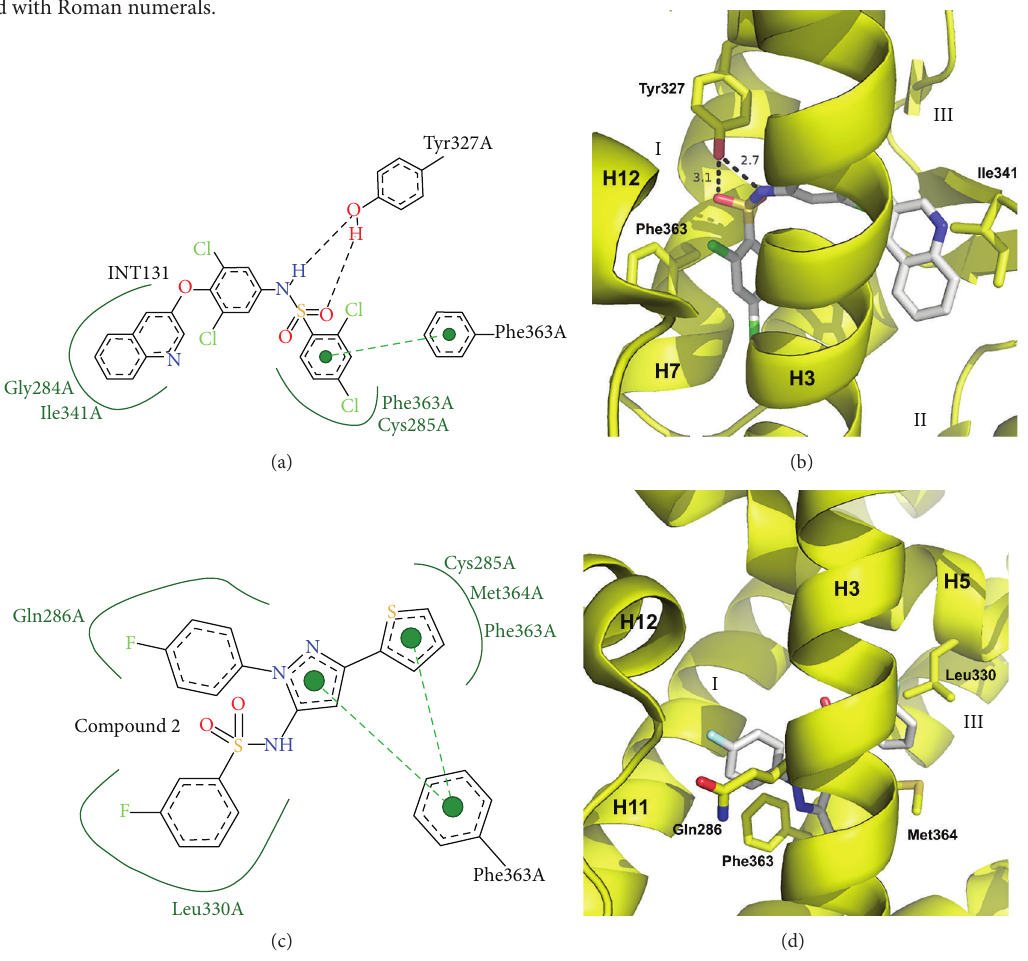
Figure 6: Crystal structures of sulfonamide containing PPAR 𝛾 partial agonists. (a) Poseview map of INT131. (b) Crystal structure of INT131 bound to the PPAR 𝛾 ligand binding domain. PDB: 3FUR [60]. (c) Poseview map of Compound 2. (d) Crystal structure of Compound 2 bound to the PPAR 𝛾 ligand binding domain. PDB: 2G0G [58]. The branches of the ligand binding pocket have been labelled with Roman